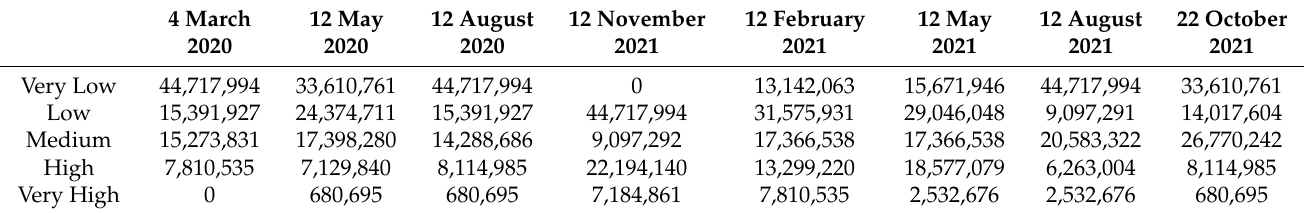
Table 5. Number of the German population endangered with a certain level of vulnerability over time.